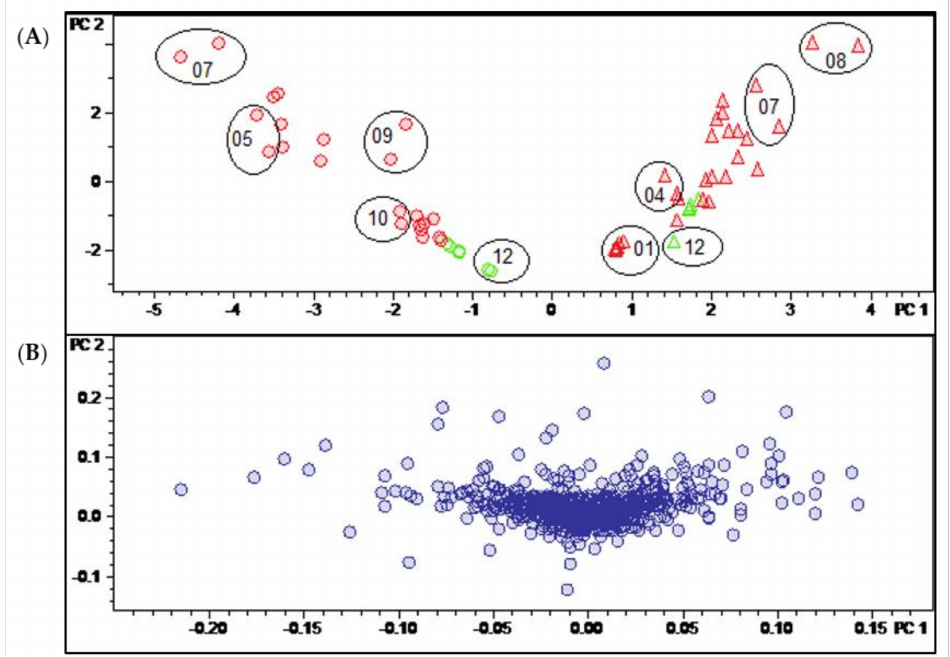
Figure 3. ( A ) Scores and ( B ) loadings plot of the PCA model obtained with Pareto-scaled variable data. PC1 (explaining 28.9% of the total variance in the data) and PC2 (explaining further 18.6% of the total variance). Legend for ( A ): round dots = B . sempervirens var. suffruticosa ; triangle = B . sempervirens var. arborescens ; red = leaf; green = twig; number = month; circle = related technical replicates ( n = 2; quality control (QC) n =